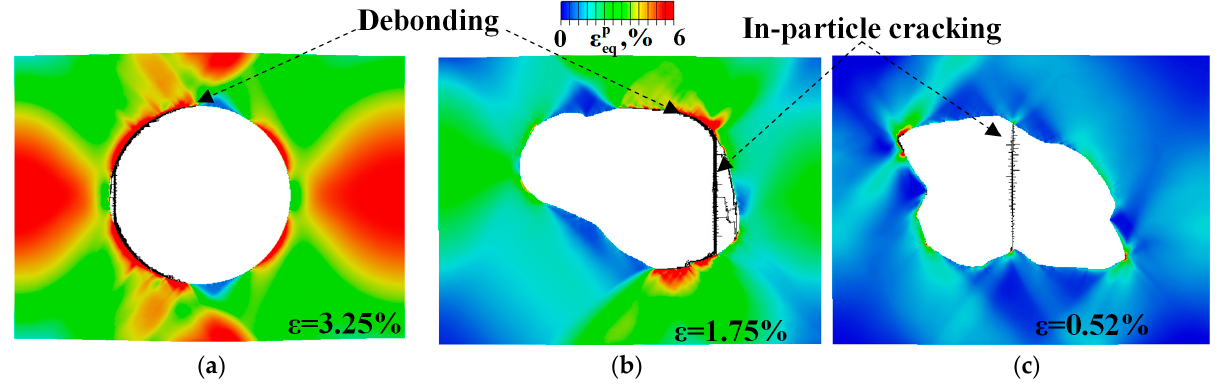
( b ) Figure 14. Stress–strain curves under tension (NRS) and tension after cooling (RS) of the composites with di ff erent particle materials and an Al6061 matrix ( a ). Corresponding elongation of composites at the fracture onset vs. particle strength ( b ). 3.2. Particle Shape and Volume Fraction The results discussed in Section 3.1 are valid for a particle with a distinct interface curvature. However, in the manufacturing of composites by the in situ methods the par- ticles commonly have circular shapes, which might improve the composite’s strength (see, e.g., [28]). Furthermore, in the case of solid-phase sintering, we also observe particles of di ff ering shapes, including round and elliptical particles (Figure 4c). Let us look at the e ff ect of the particle shape on the composite’s deformation behavior. We have performed the calculations for a composite reinforced by a perfectly round particle (Figure 15a) and a particle of an irregular experimentally observed shape but with a less distinct interfacial curvature (Figure 15b) than in the basic case discussed above (Figure 15c). It has been found that with a decrease in the interfacial curvature, the particle fracture mechanism